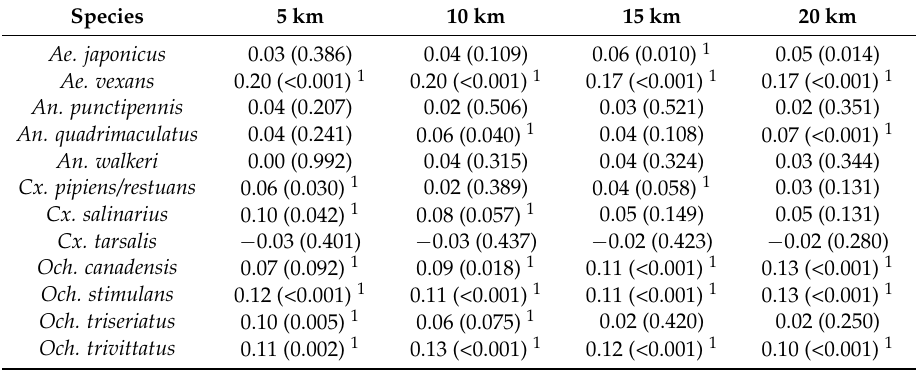
Table 1. Spatial autocorrelation results for geospatial distribution of WNV vector abundance among the 30 southern Ontario HUs. Global Moran’s index values are presented with their p -value in